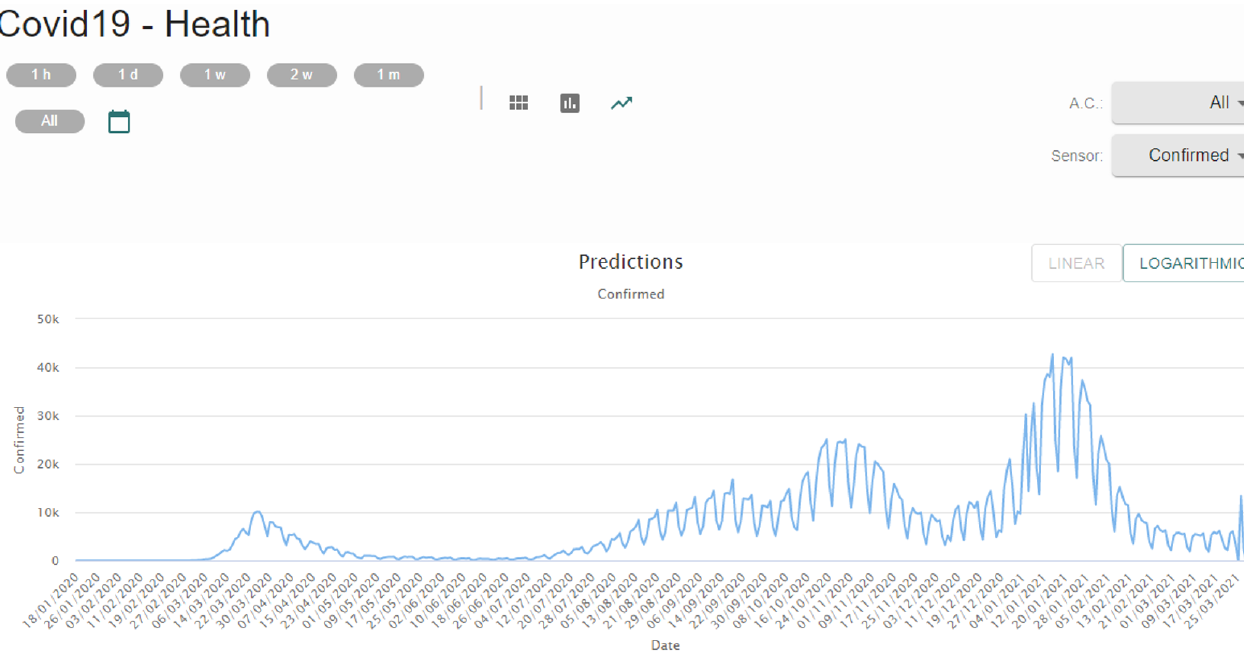
Figure 10. Prediction of confirmed cases in Spain since the beginning of the